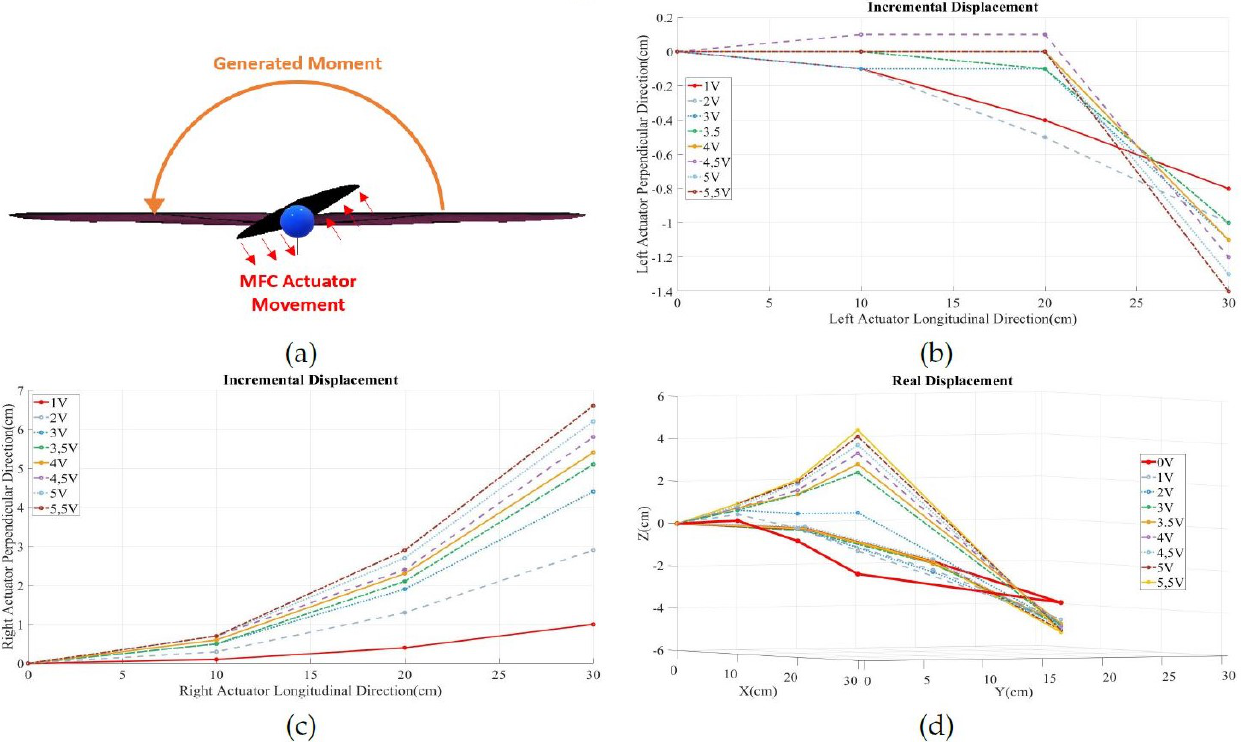
Figure 9. Tail Twist Feasibility Experiments. ( a ) Shows the potential behavior of the tail. ( b ) Shows the incremental displacement of the left actuator. ( c ) Shows the incremental displacement of the right actuators. ( d ) Shows the incremental tail twist 3D